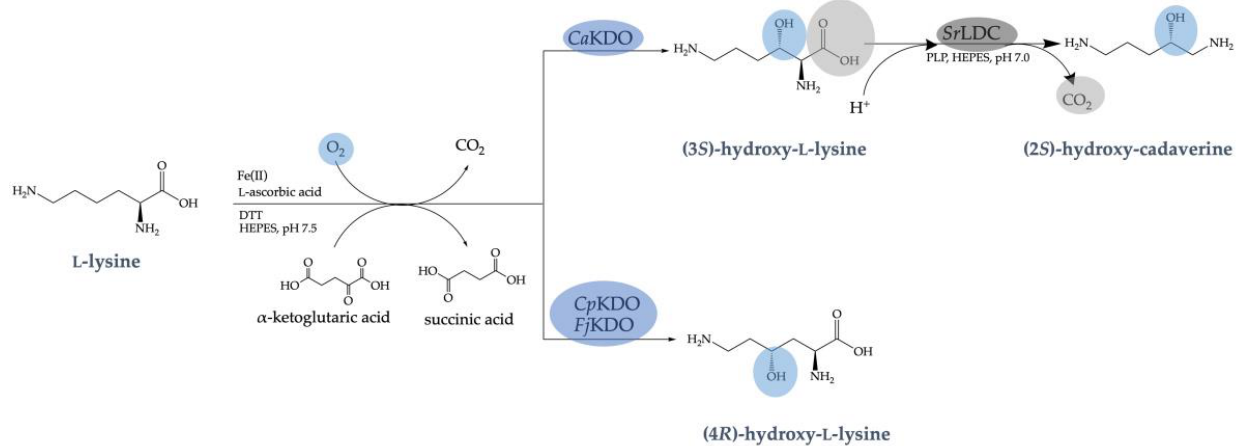
Figure 1. Reaction scheme of the stereoselective hydroxylation of the L-lysine side chain in the 4-position catalyzed by KDO from Chitinophaga pinensis ( Cp KDO) and KDO from Flavobacterium johnsoniae ( Fj KDO) or in the 3-position catalyzed by KDO from Catenulispora acidiphila ( Ca KDO) followed by decarboxylation to (2S)-hydroxy cadaverine catalyzed by Sr LDC from Selenomonas ruminantium .